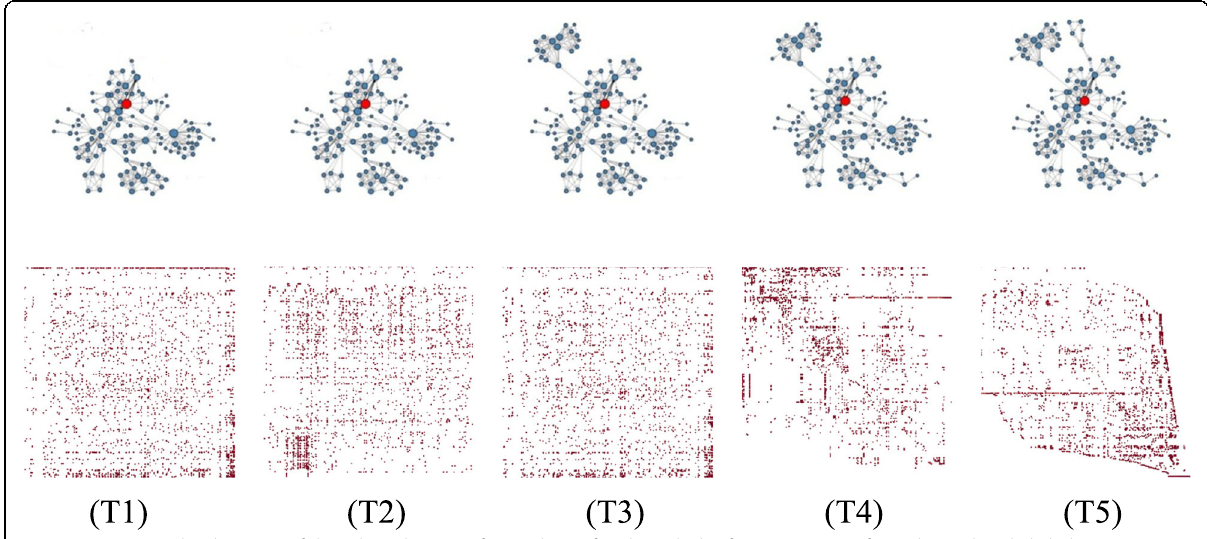
Fig. 15 Inspecting the dynamics of the selected group of co-authors of Jock Mackinlay from Fig. 14 in a force-directed node-link diagram indicates the growth of the co-author network over time, from (T1) to (T5) (top row). In a corresponding adjacency matrix in different reordering strategies, the group building can be further refined in a visual way (bottom row). However, in the matrix example here, it is quite difficult to select individual nodes owing to the original dataset size. The selected co-author group in the node-link diagram was based on time step